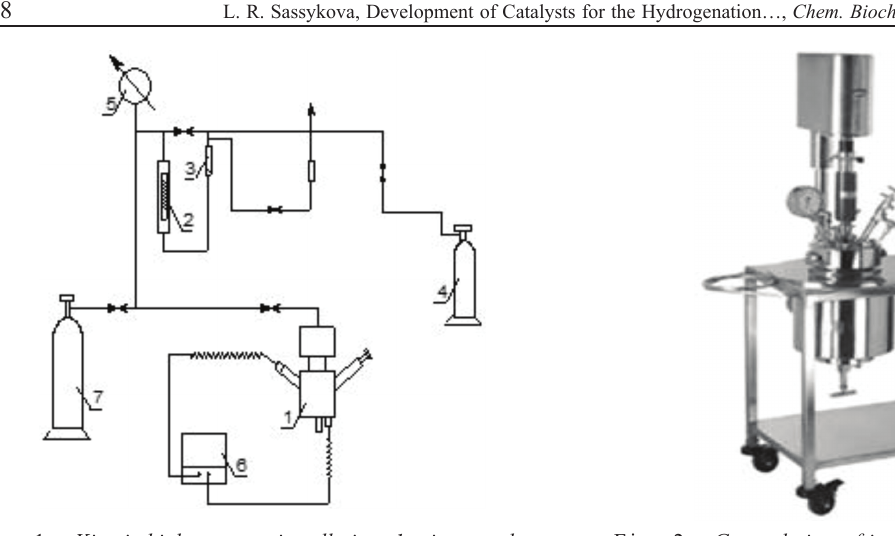
Fig. 2 – General view of installation with the autoclave Am- arEquipments Pvt. Ltd. (India)